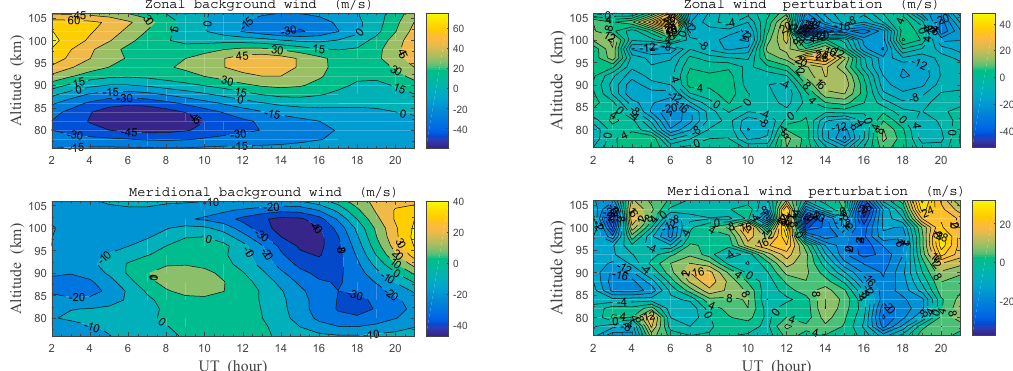
Figure 4. The mean background horizontal wind ( left panel ) and wind perturbations ( right panel ) measured simultaneously with meteor radar at Shisanling (40.3° N, 116.2° E) on 30 May 2012. Positive values in the figures indicate the northward meridional wind or the eastward zonal wind.